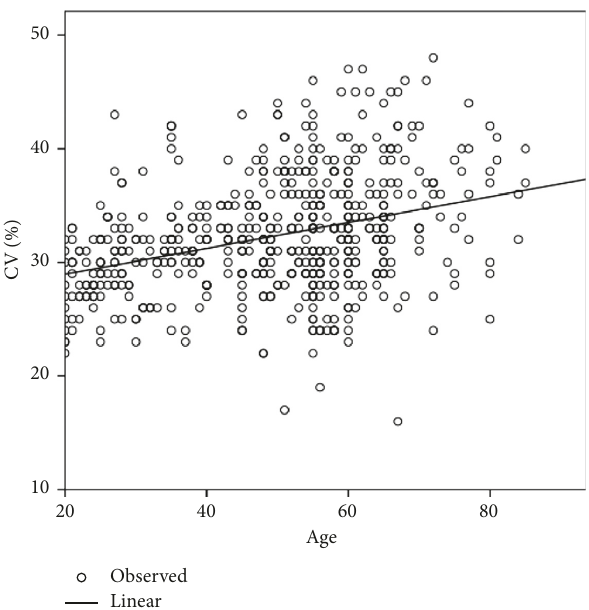
Figure 3: Relationship between the coefficient of variation (CV) in cell area and age in Egyptian subjects with healthy eyes.